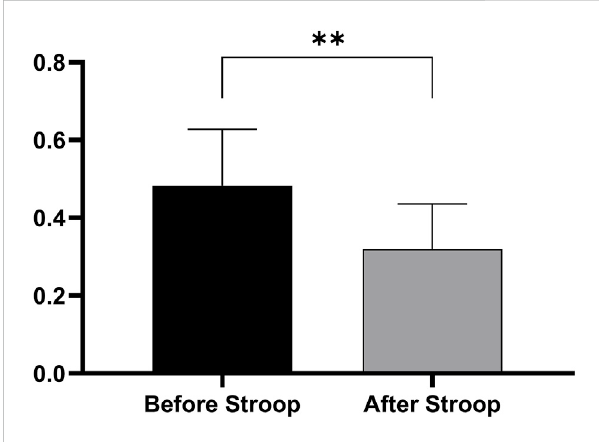
FIGURE 2 Changesinworkef fi ciencyofLCTinparticipantsbeforeandafter Stroop